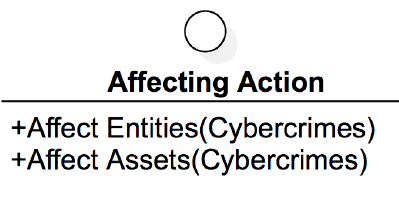
Figure 21. Attackers’ Actions.